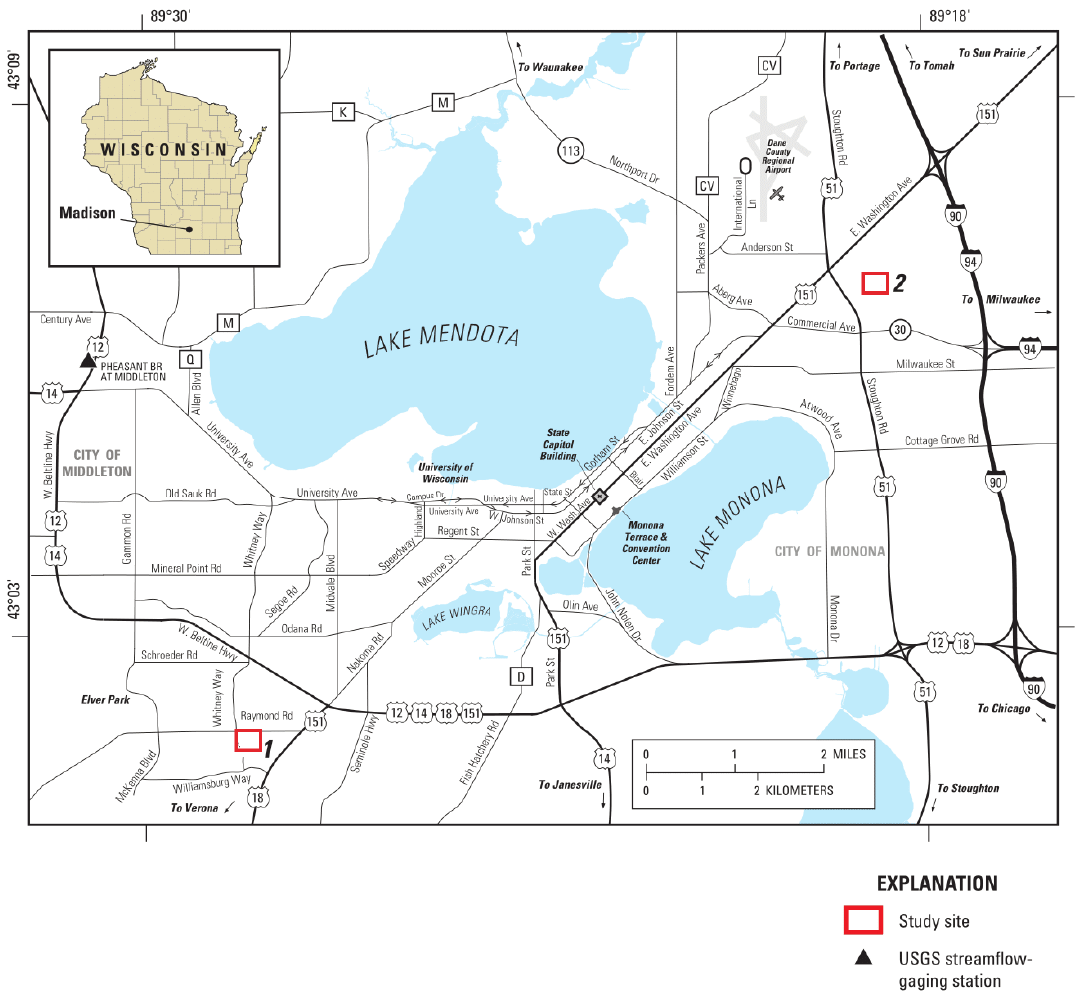
Figure 1. Location of the residential basin (1) and commercial parking lot (2) study areas, Madison, Wisconsin. Settling velocities were determined by use of a settling column of 15.2 cm in diameter and 1.8 m high fitted with a series of sample ports spaced vertically throughout the column. Measurements of solids concentration in the water were collected at each sampling port over time. The concentration measured in samples from each port location representing the settling depth and the sample time